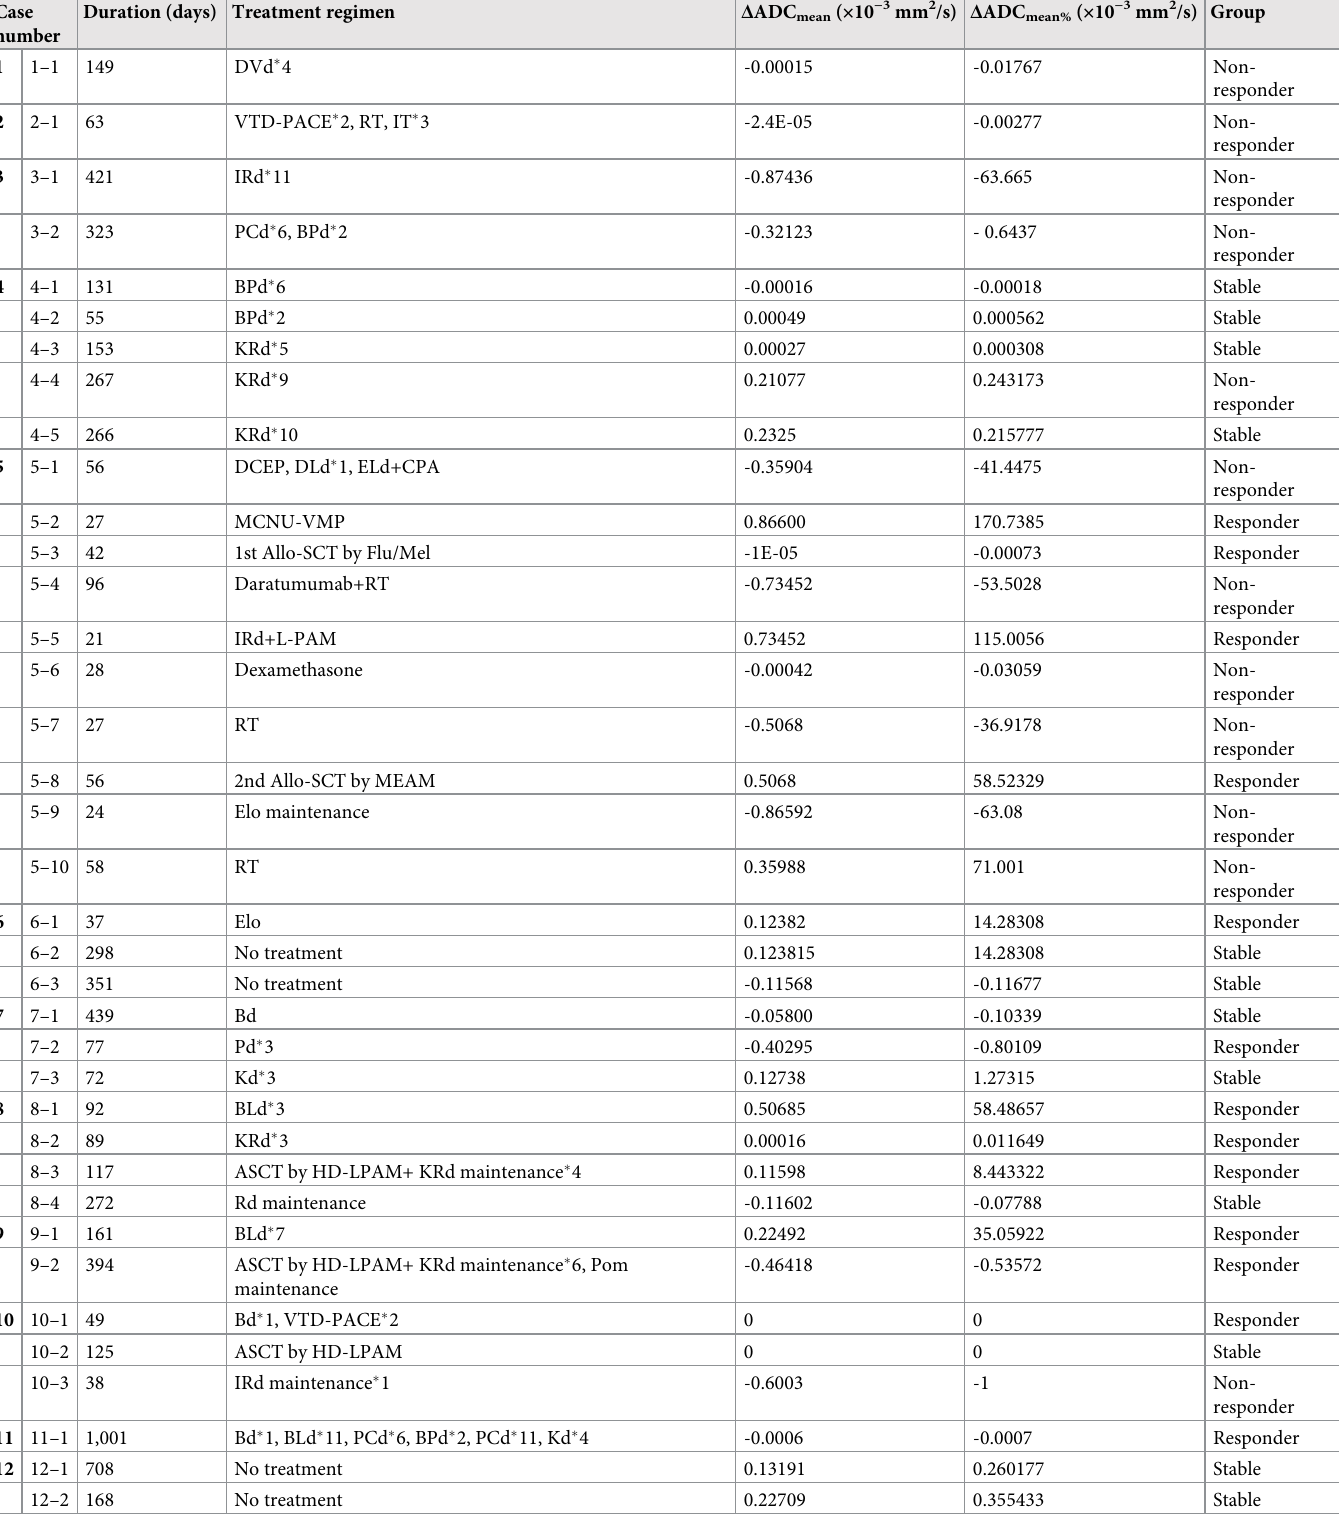
Table 3. Clinical course of patients in terms of treatment response. Case Duration (days) Treatment number